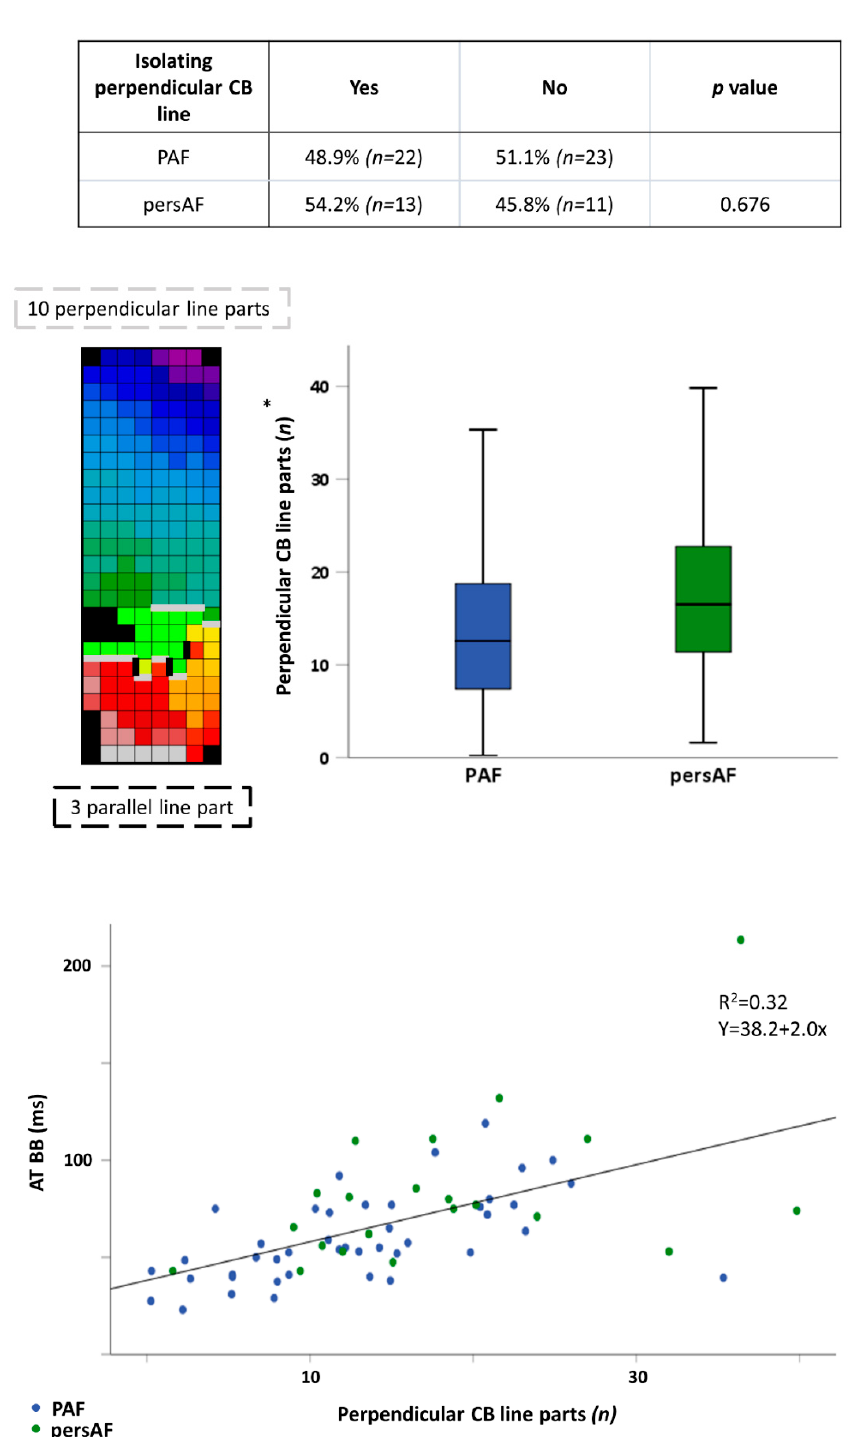
Figure 2. Paroxysmal vs. persistent AF patients: conduction disorders at Bachmann’s Bundle. The table in the upper panel shows percentages of PAF and persAF patients with an isolating perpendicularly orientated CB line. The left part of the middle panel illustrates how the number of parallel and perpendicular orientated CB line parts was determined. An activation map is depicted with gray perpendicular CB line parts and black parallel CB line parts. The right part of the middle panel shows the difference in perpendicular CB line parts between PAF and persAF patients. The scatterplot in the lower panel depicts the relation between amount of perpendicular CB line parts and AT at BB in all patients. BB: Bachmann’s bundle; CB: conduction block; PAF: paroxysmal AF; persAF: persistent AF; TAT: total activation time; * p =